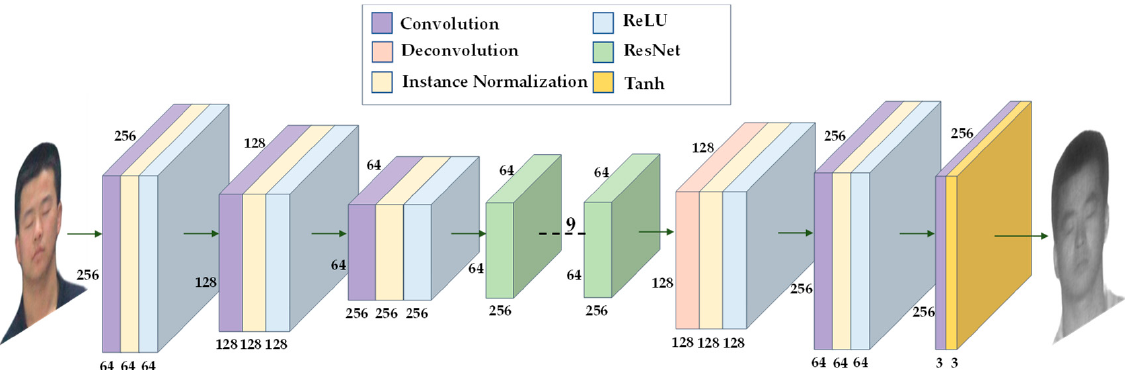
Figure 4. The architecture of the generator in the CycleGAN.